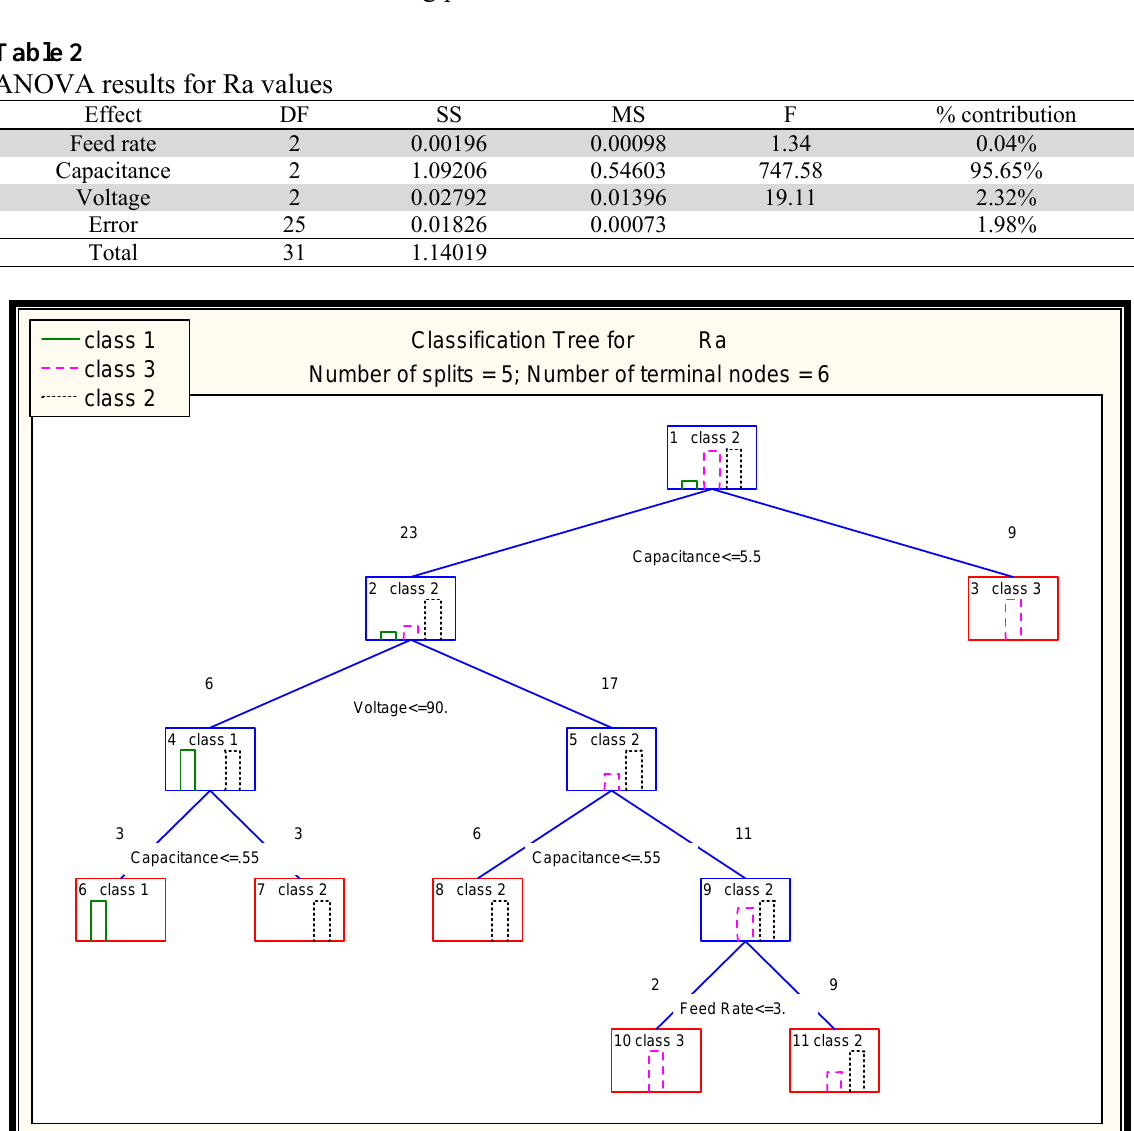
Fig. 2. Classification tree for Ra (three